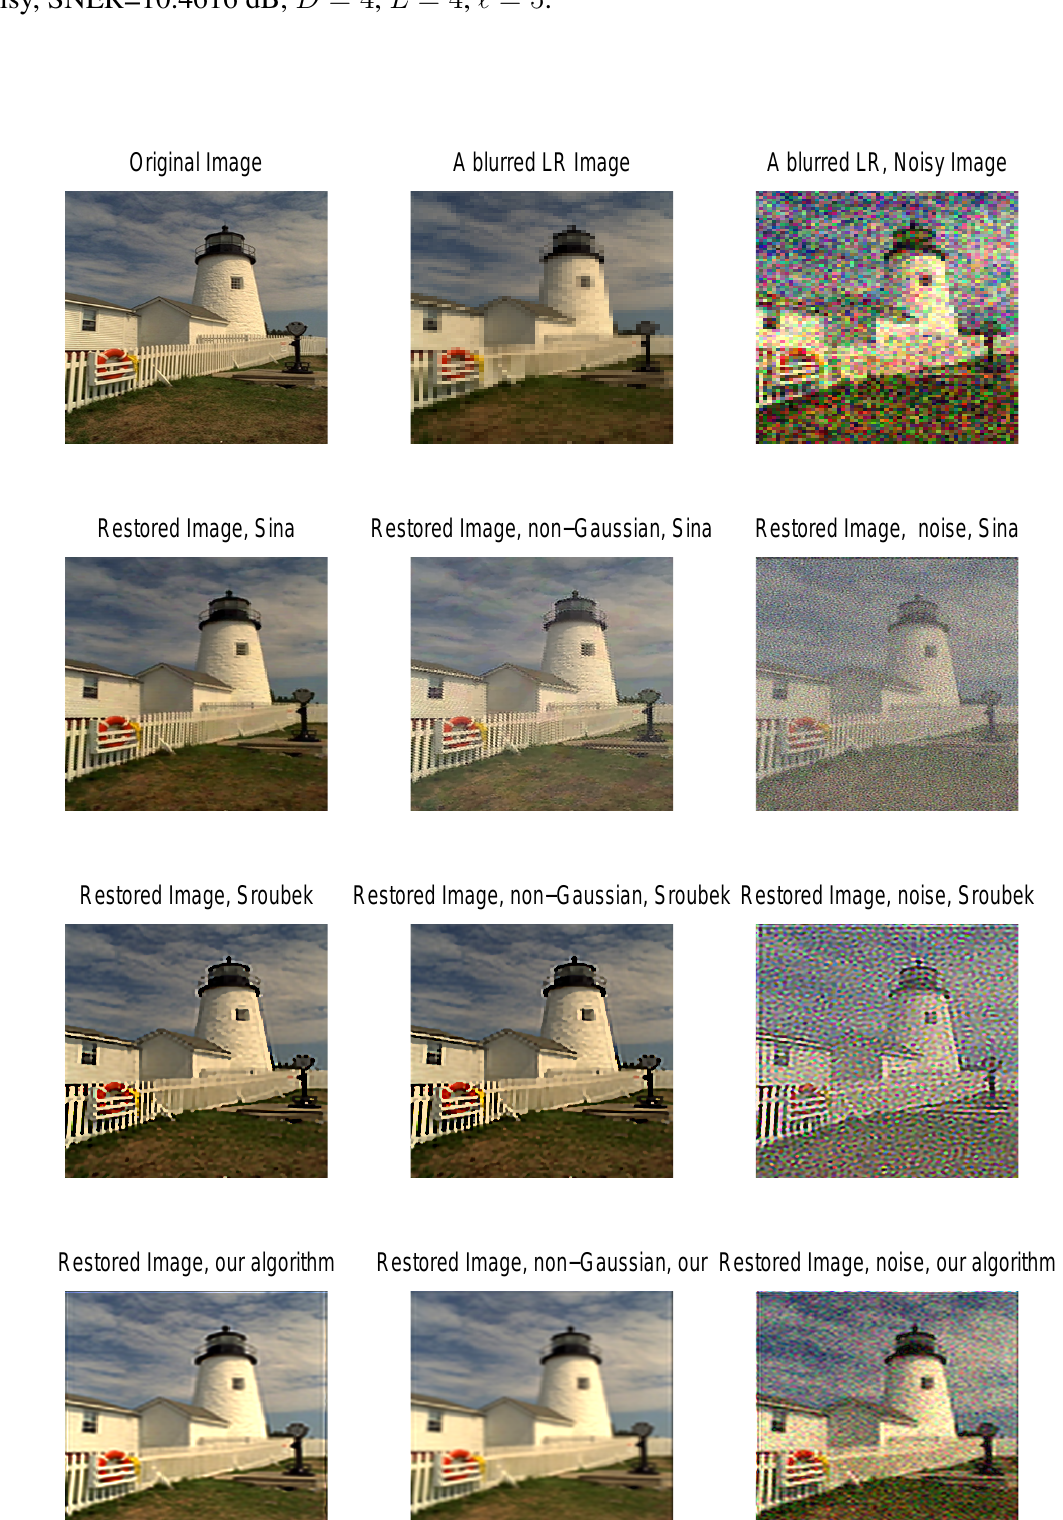
Figure 6. Simulation results for 12 blurred LR images of the lighthouse, in noiseless, and noisy, SNER=10.4616 dB, D = 4 , L = 4 , ‘ = 5